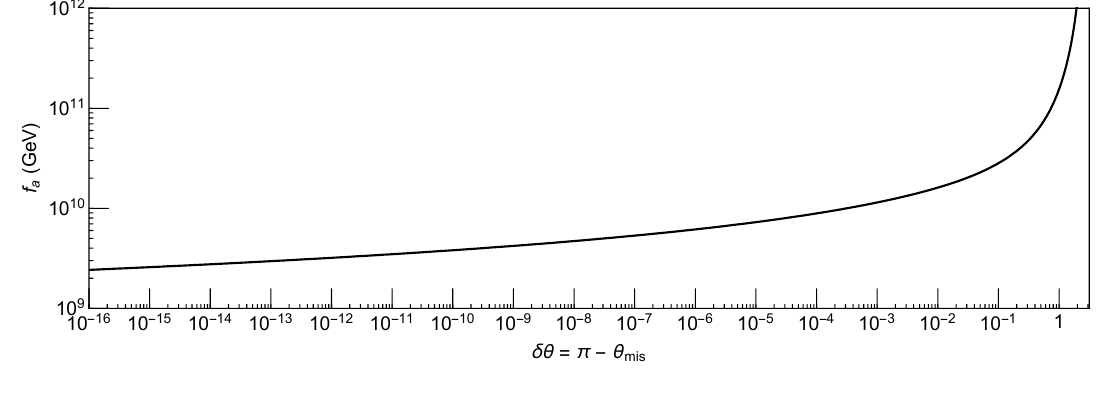
Figure 1 . Insensitivity of f a to very small shifts from the